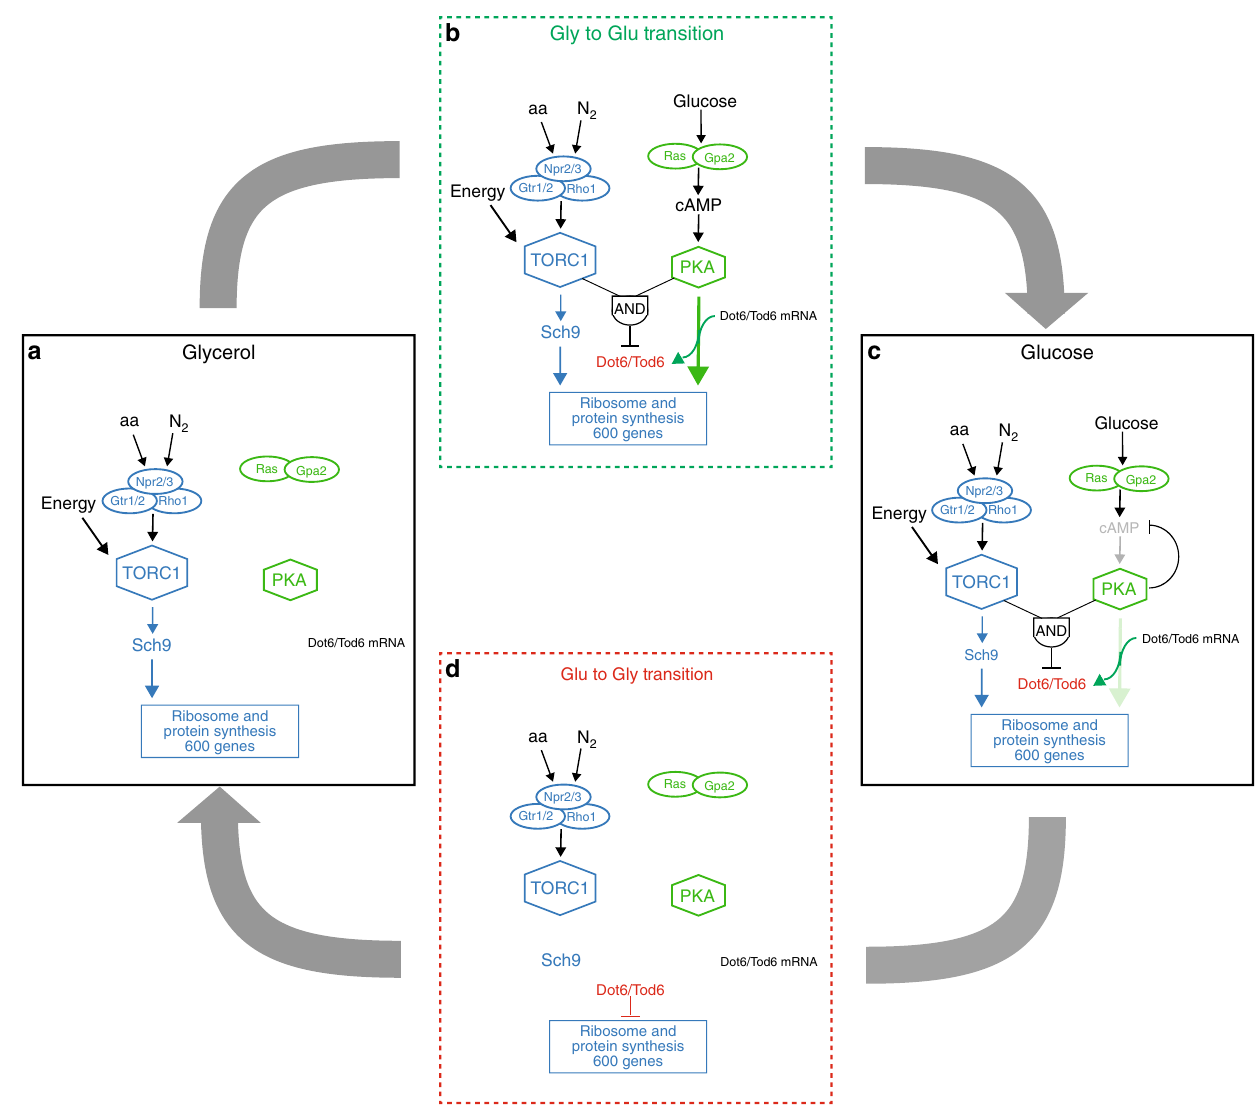
Fig. 5 Model of the TORC1 – PKA signaling circuit. a The TORC1 pathway promotes expression of the protein and ribosome synthesis genes (and thus cell growth) in glycerol medium. b Immediately after cells are exposed to glucose, the PKA kinases act in parallel with the TORC1 pathway to drive a pulse of ribosome and protein synthesis gene expression. c Then, as cells reach steady-state growth in glucose, the gene expression levels are reduced (due to negative feedback in the PKA pathway) so that they are about 2.5-fold higher than in glycerol. d Once glucose is depleted, the repressor proteins Dot6/ Tod6 (synthesized due to activation of the PKA pathway, see b ) are dephosphorylated due to inactivation of TORC1 and PKA, move to the nucleus, and recruit Rpd3L to the protein and ribosome synthesis genes. This causes dramatic downregulation of the ribosome and protein synthesis genes until Dot6/ Tod6 are degraded (30 – 60 min later), and the circuit returns to its original (glycerol growth) state. See text for further